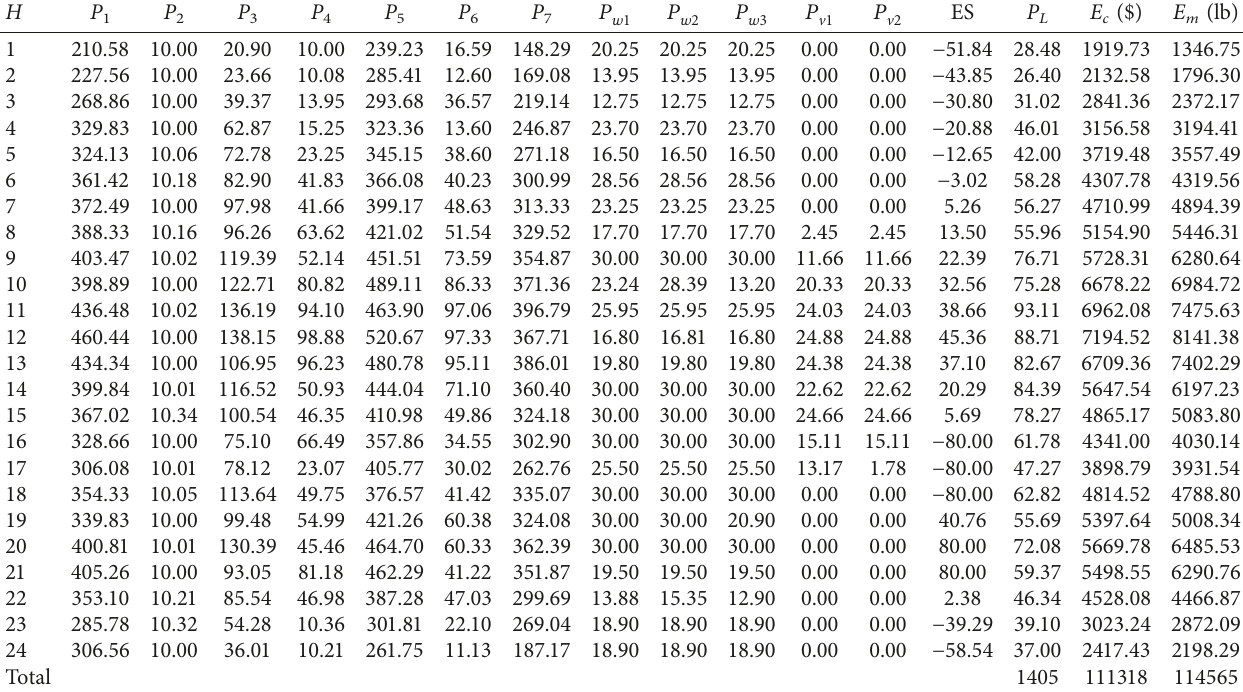
Table 12: Optimal compromise results for Case 4.